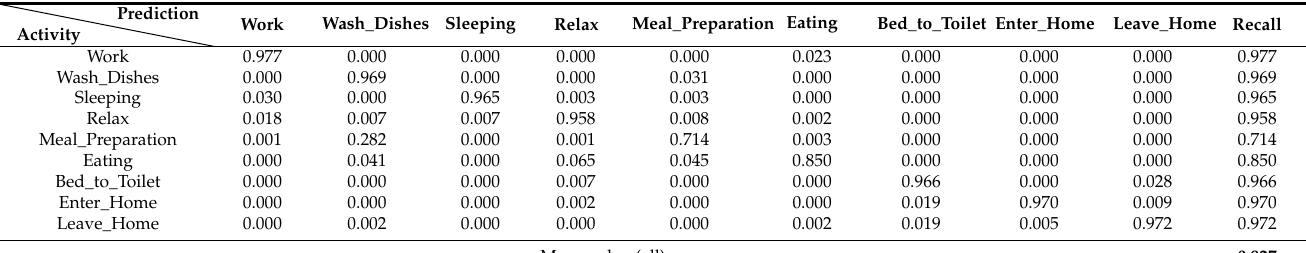
Table 6. Confusion Matrix for Activities and Evaluation of model with Predicted Previous Activity Feature. Prediction Activity